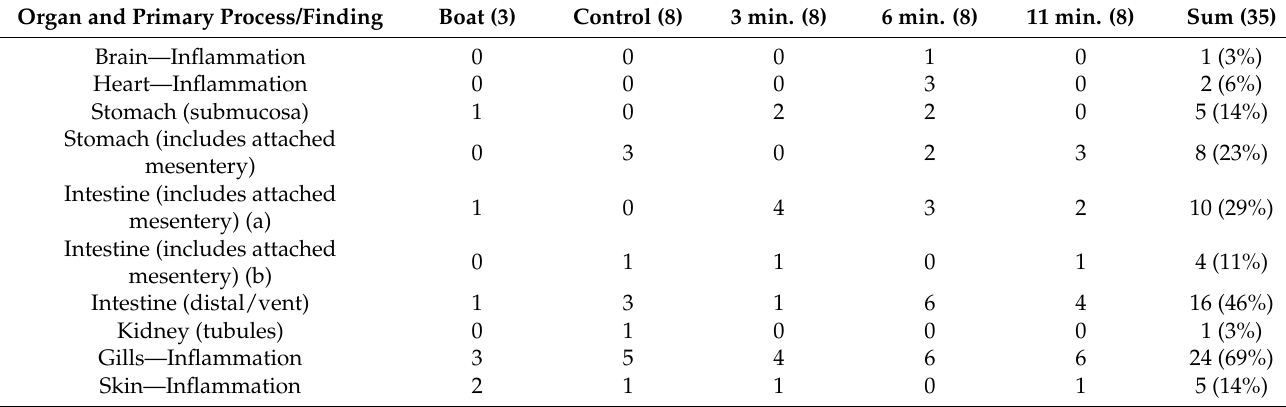
Table 2. The count of fish with each tissue abnormality by treatment type and the number of fish in each treatment (in parentheses). For the sum, in the right column, both the count and the percent are presented. Treatment types included: being sampled on the boat, a control group that was held in the laboratory but not exposed to air, and three treatment groups that were exposed to air for 3, 6, or 11